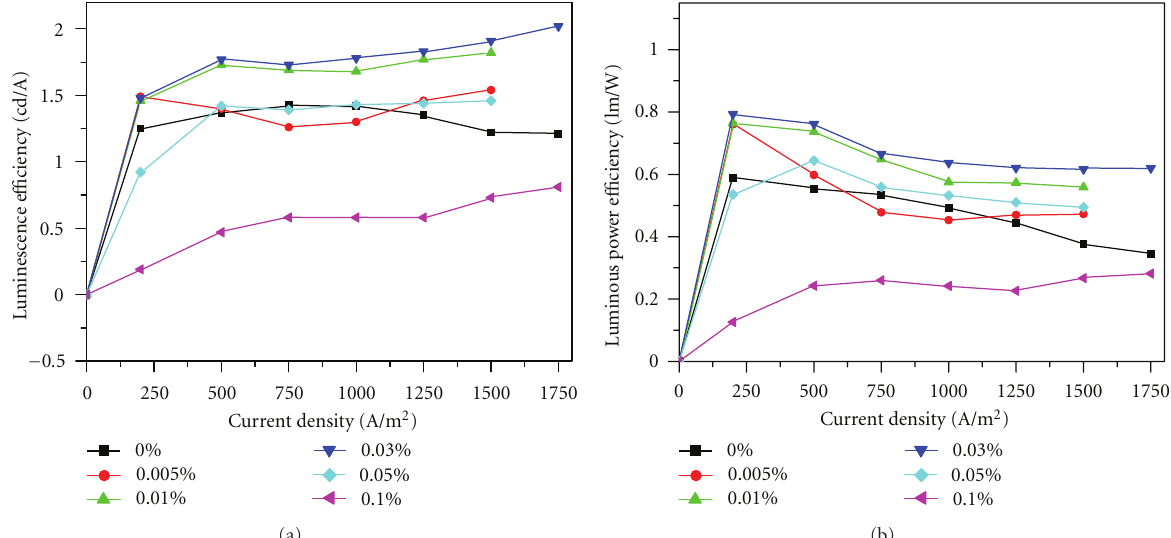
Figure 5: The e ff ect of graphene concentration on luminous e ffi ciency (a) and luminous power e ffi ciency (b) of PLEDs using PEDOT:PSS/graphene nanocomposite as the hole-injection